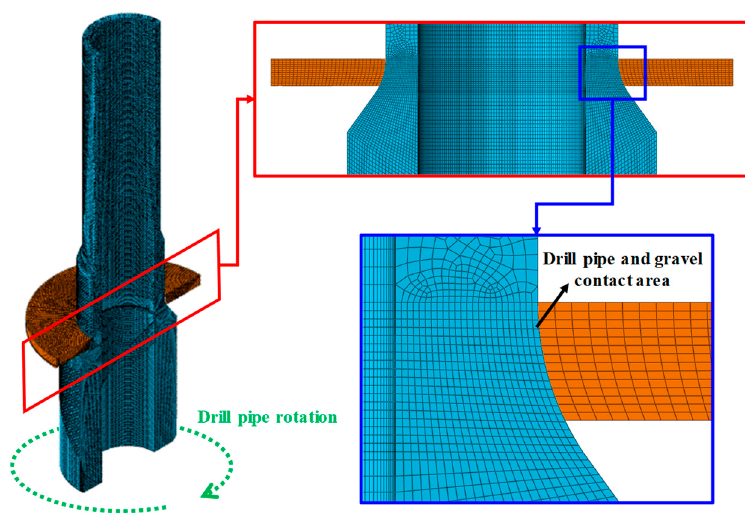
Figure 8. Structure size of drill pipe and 3D drill pipe-gravel solid model.